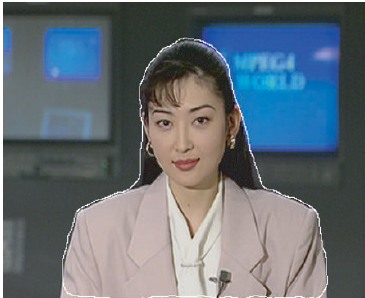
Figure 7: Segmentation result on Akiyo sequence.